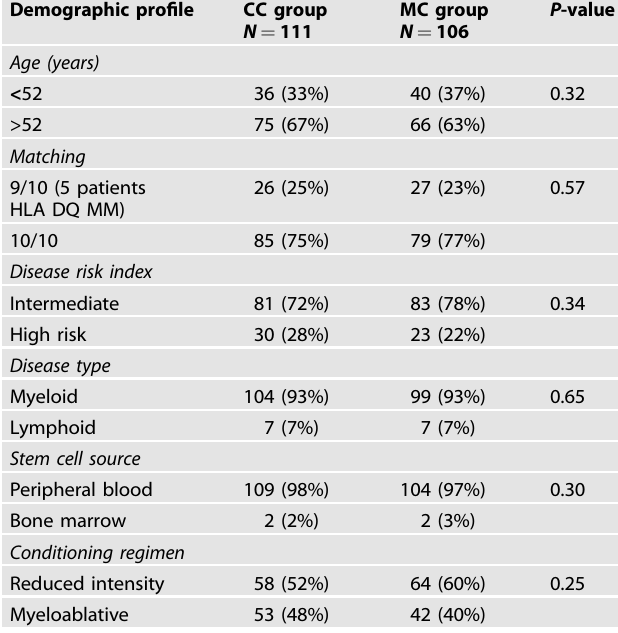
Table 1. Demographic characteristics of our study